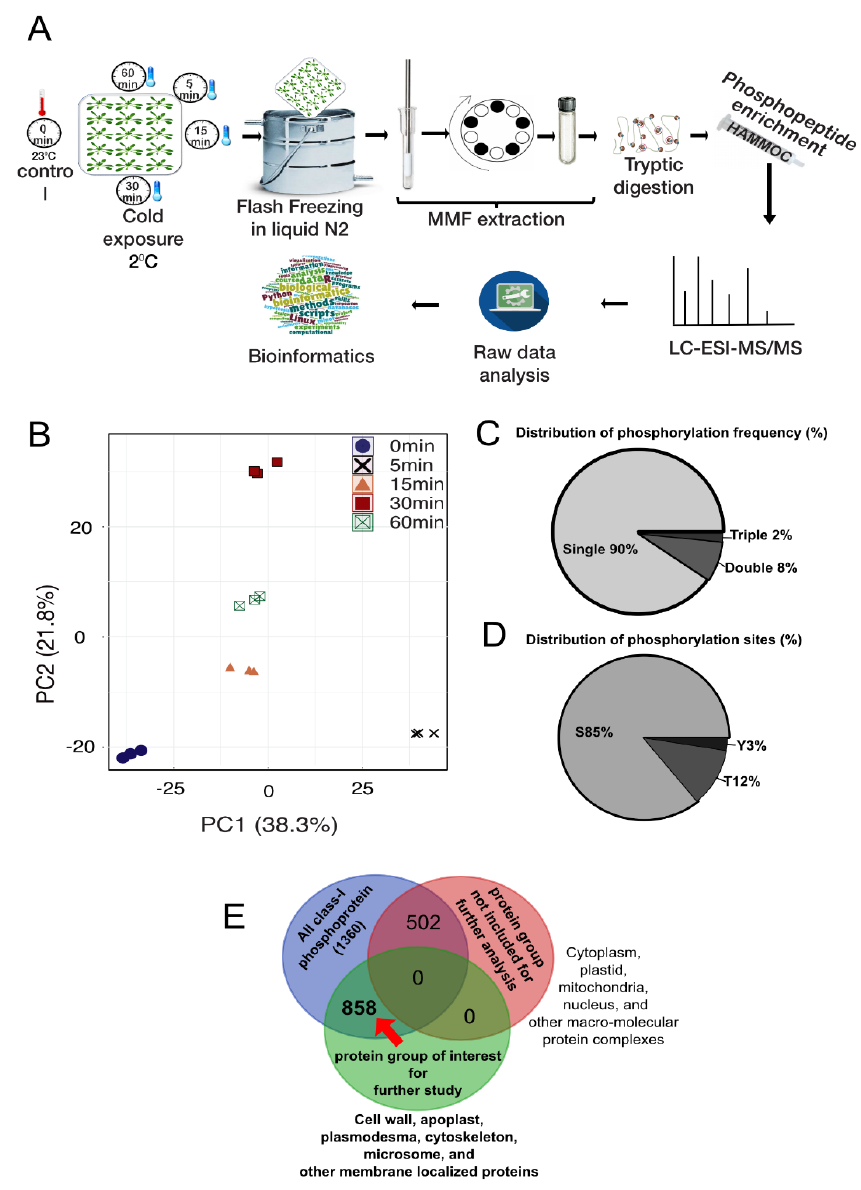
Figure 1. Analysis of the cold-responsive phosphoproteins in Arabidopsis thaliana . ( A ) Experimental design and analytical workflow. ( B – E ) Quantitative analysis of the phosphopeptides: ( B ) Principal component analysis (PCA) of all the identified peptides (including phosphorylated and non-phosphorylated peptides). The times indicate the cold exposure duration: 5 to 60 min. ( C ) Frequency distribution of all the identified phosphopeptides based on the number of phosphorylation sites and phosphorylated amino acids. ( D ) Frequency of phosphosites per peptide: S, serine; T, threonine; Y, tyrosine. ( E ) Gene-ontology enrichment of cellular localization and the distribution of the proteins of interest. Class-I phosphoprotein: phosphopeptides with a mascot variable modification confidence score ≥ 0.75. The red arrow indicates the number of proteins comes from the MMFs.